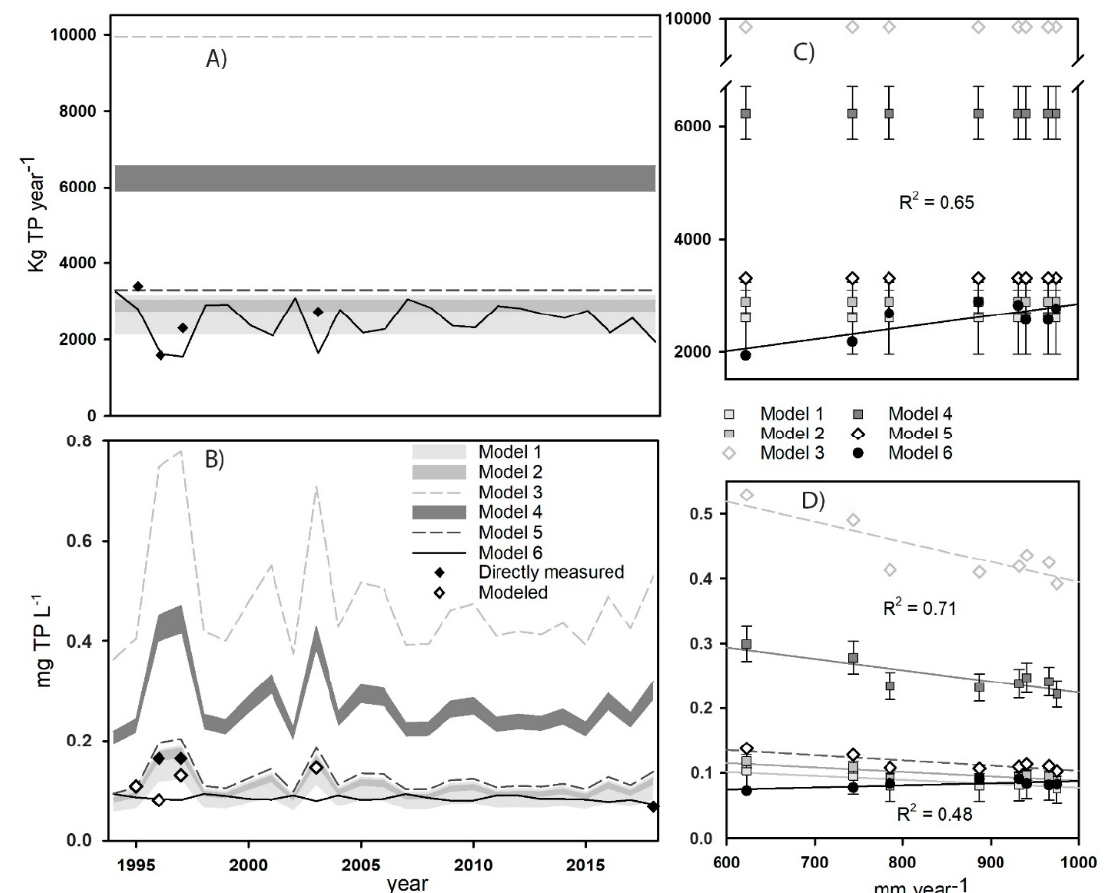
Figure 6. Annual external TP-loading (TP External ) ( A ) and annual TP-concentration (TP Annual ) ( B ) in Lake Hindemade (HIN) from establishment in 1994 to 2018 modeled using six methods. TP External ( C ) and TP Annual ( D ) in relation to annual precipitation in the HIN catchment from 2011 to 2018. ( C ) The relationship between annual precipitation and Model 6 (linear regression, R 2 = 0.65, p < 0.05). ( D ) Model 6 shows a positive relationship between TP Annual and precipitation (linear regression R 2 = 0.48, p < 0.05), while all other methods show a decreasing regression (linear regression, R 2 = 0.71, p < 0.05). R and p values are only given for significant relationships ( p < 0.05).